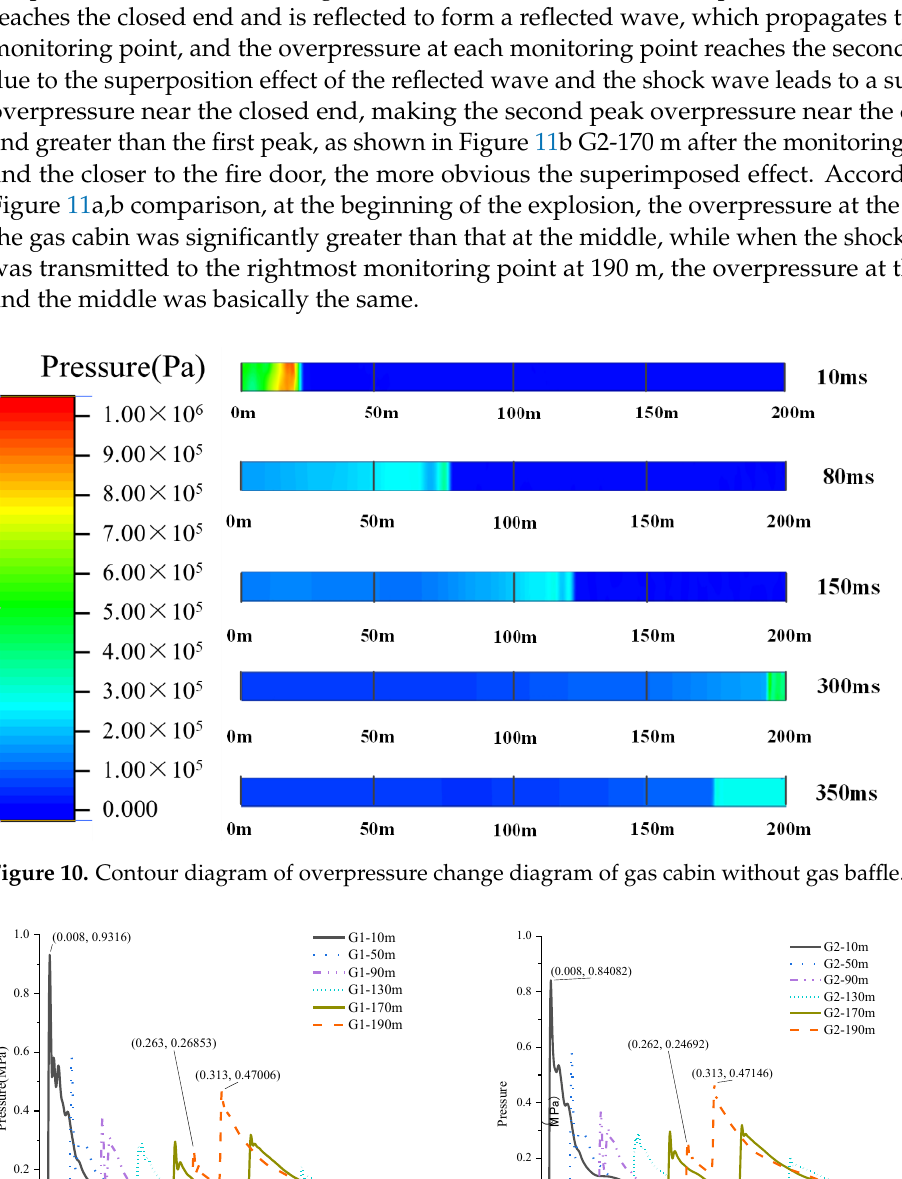
Figure 10. Contour diagram of overpressure change diagram of gas cabin without gas baffle .